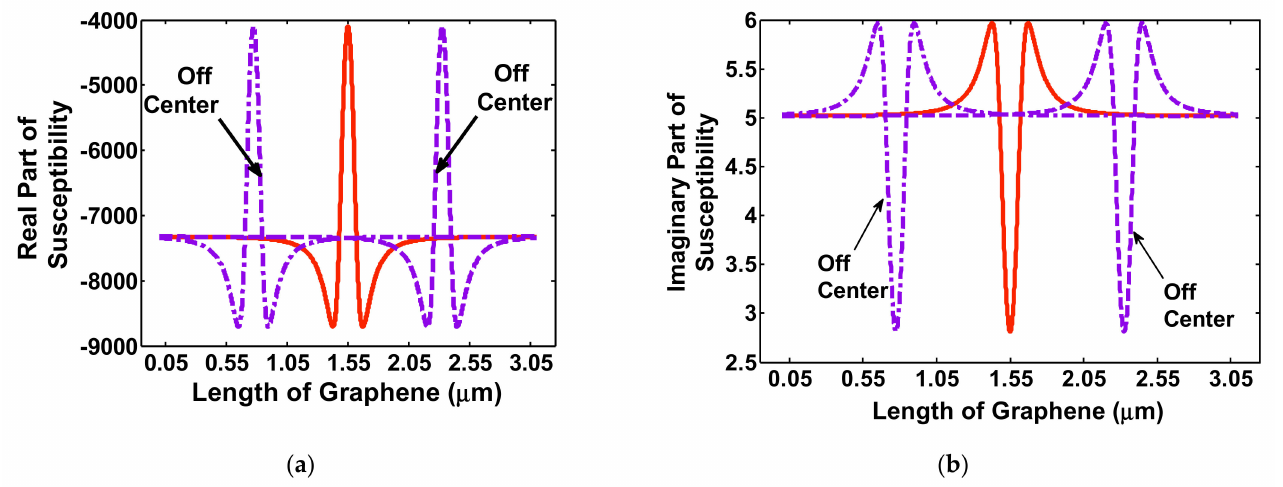
Figure 10. The ( a ) real and ( b ) imaginary parts of susceptibility for different positions of QD ( ε b = 12, r QD = 100 ( nm )